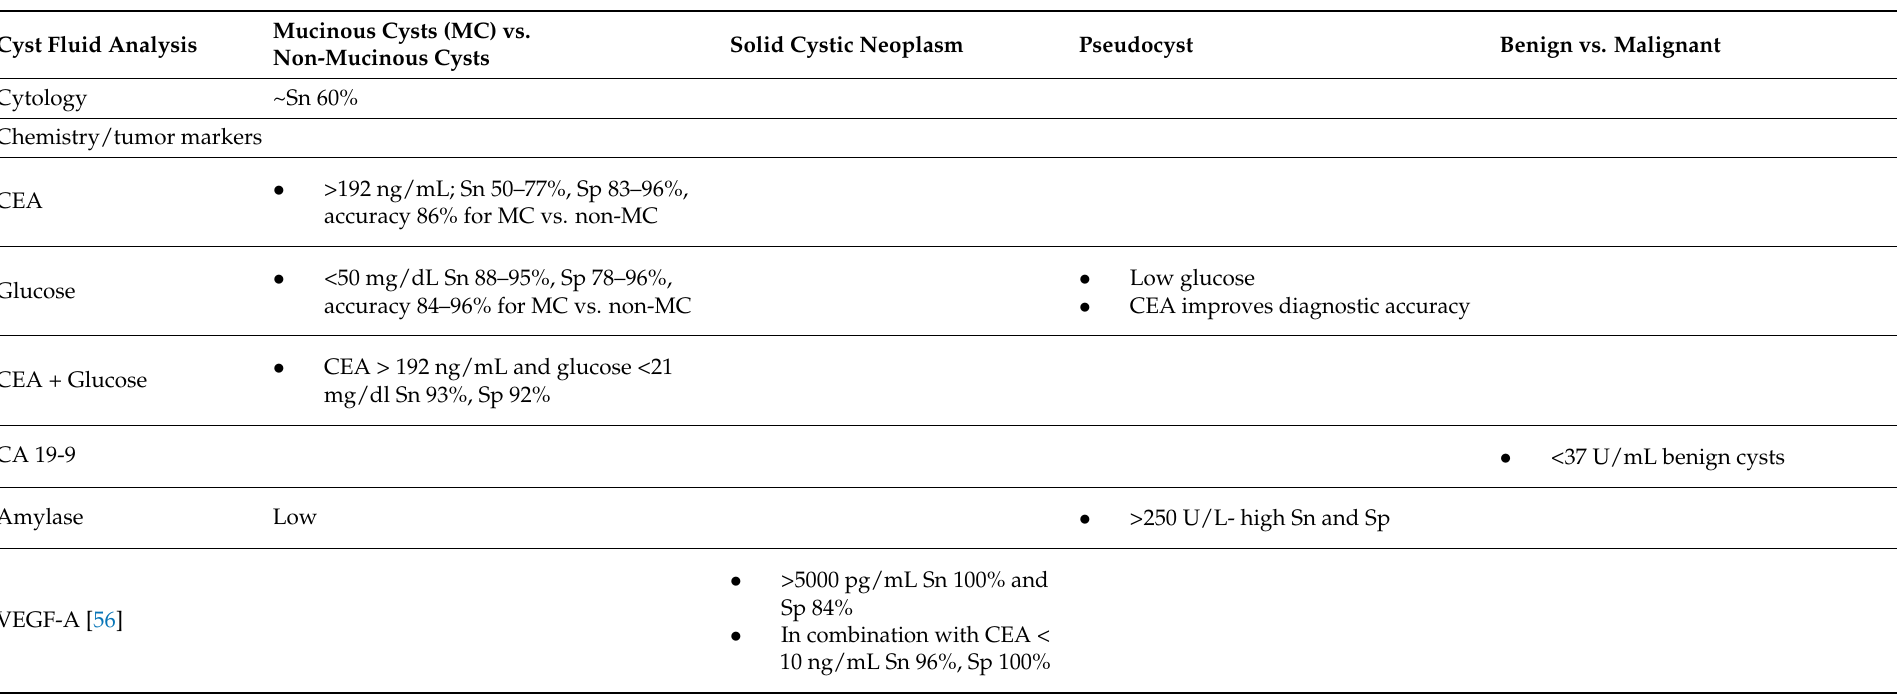
Table 2. Pancreatic cyst fluid